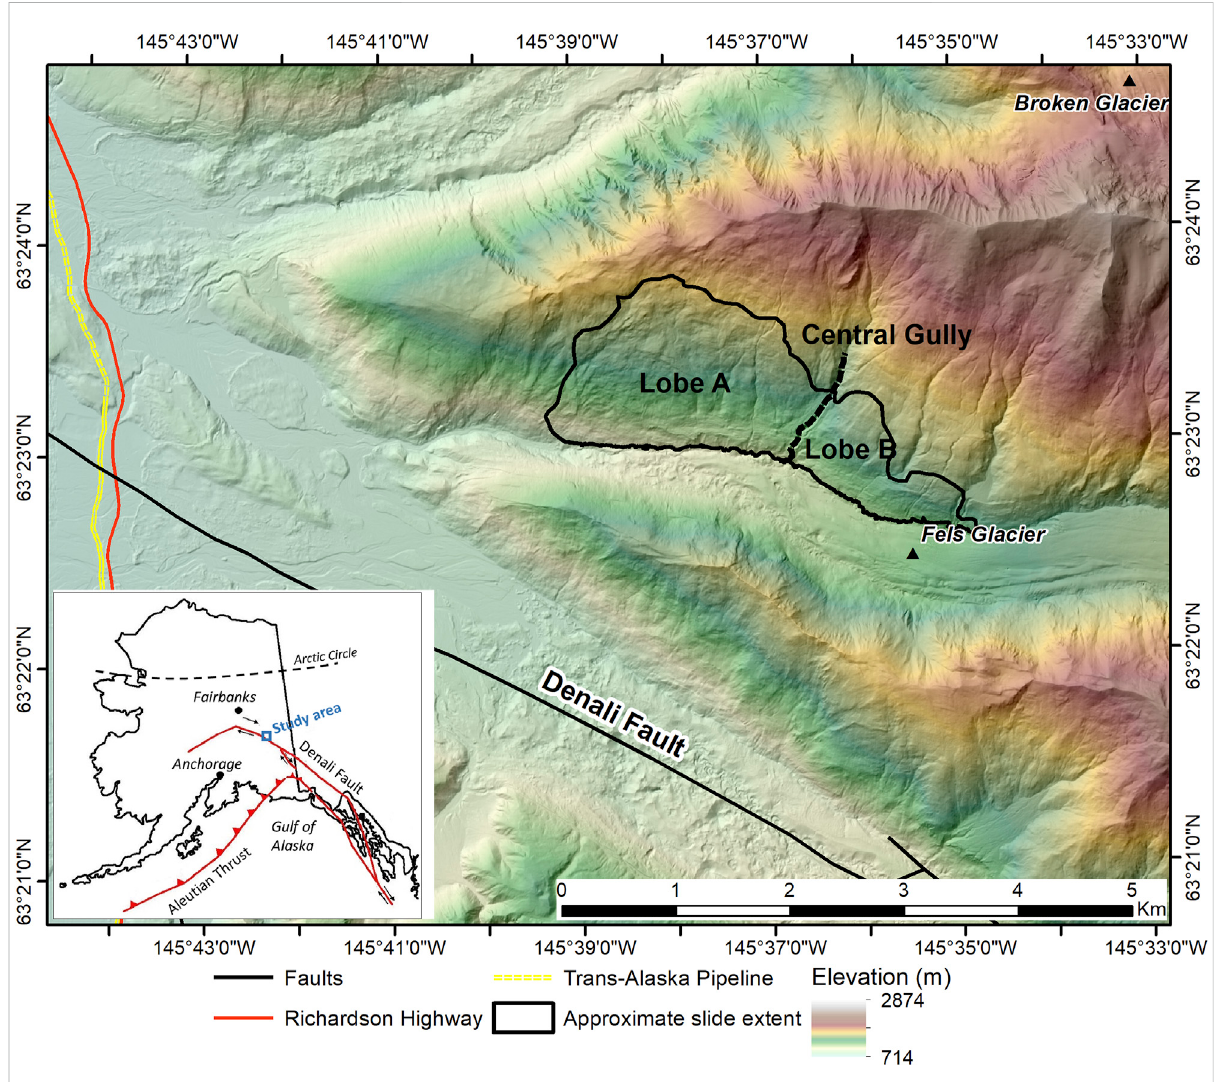
FIGURE 2 Thestudyarea.FelsslideissituatedaboveFelsGlacierwithinabout3 kmoftheDenaliFault.TheslidecomprisestwolobesAandB,separatedby a central gully. Inset map shows the study area location in